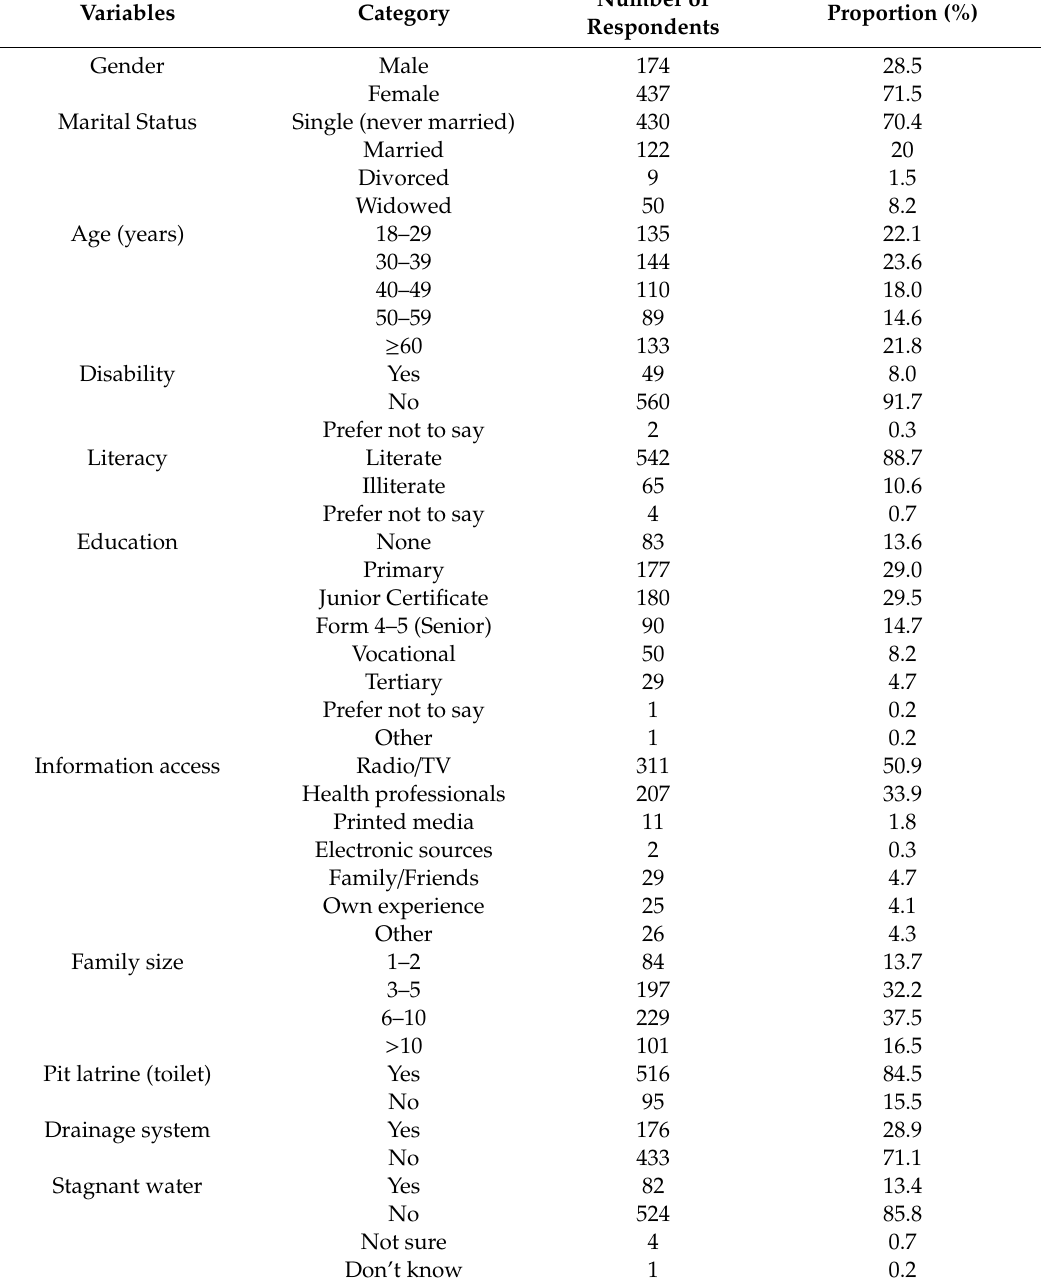
Table 1. Summary results of the socio-demographic characteristics for non-endemic areas (Serowe and Palapye) and endemic (Bobirwa) sub-districts ( n =